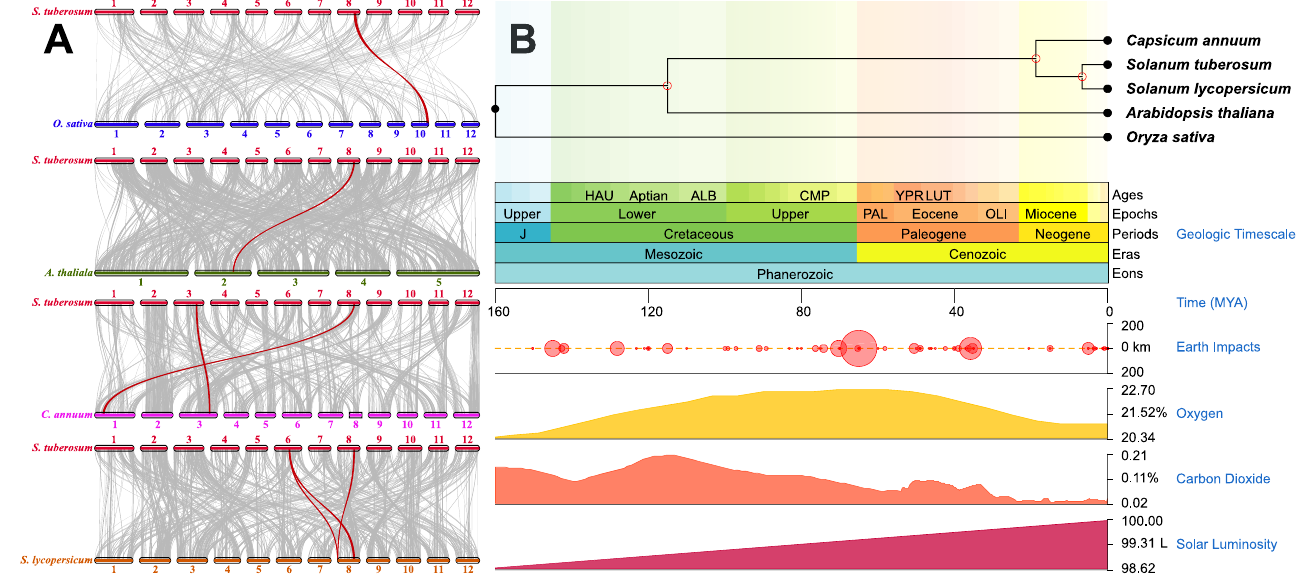
Figure 2. Collinearity analysis of SROs in S. lycopersicum , C. annuum , A. thaliana, and O. sativa . ( A ) Different species are represented by chromosomes of different colors. The red line represents homologous pairs in StSROs, and the gray line represents collinear blocks in plant genome. ( B ) Evolutionary trees of S. tuberosum and the four species mentioned above. Different background colors indicate when the species diverged. The species evolutionary tree was constructed using the online Timetree software (http://www.timetree.org accessed on 15 November 2022) [21].